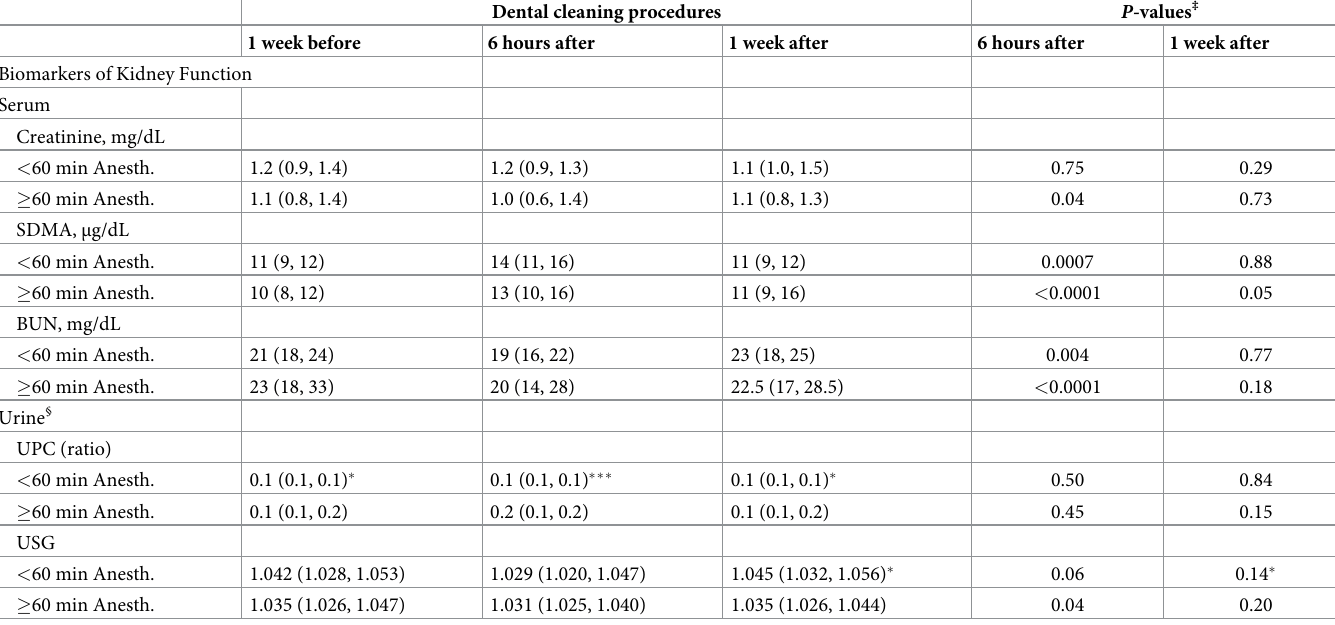
Table 4. Serum and urine kidney function biomarkers before and after general anesthesia and dental cleaning procedures in cats and dogs with periodontal disease stratified by anesthesia length (n = 62) � . Dental cleaning